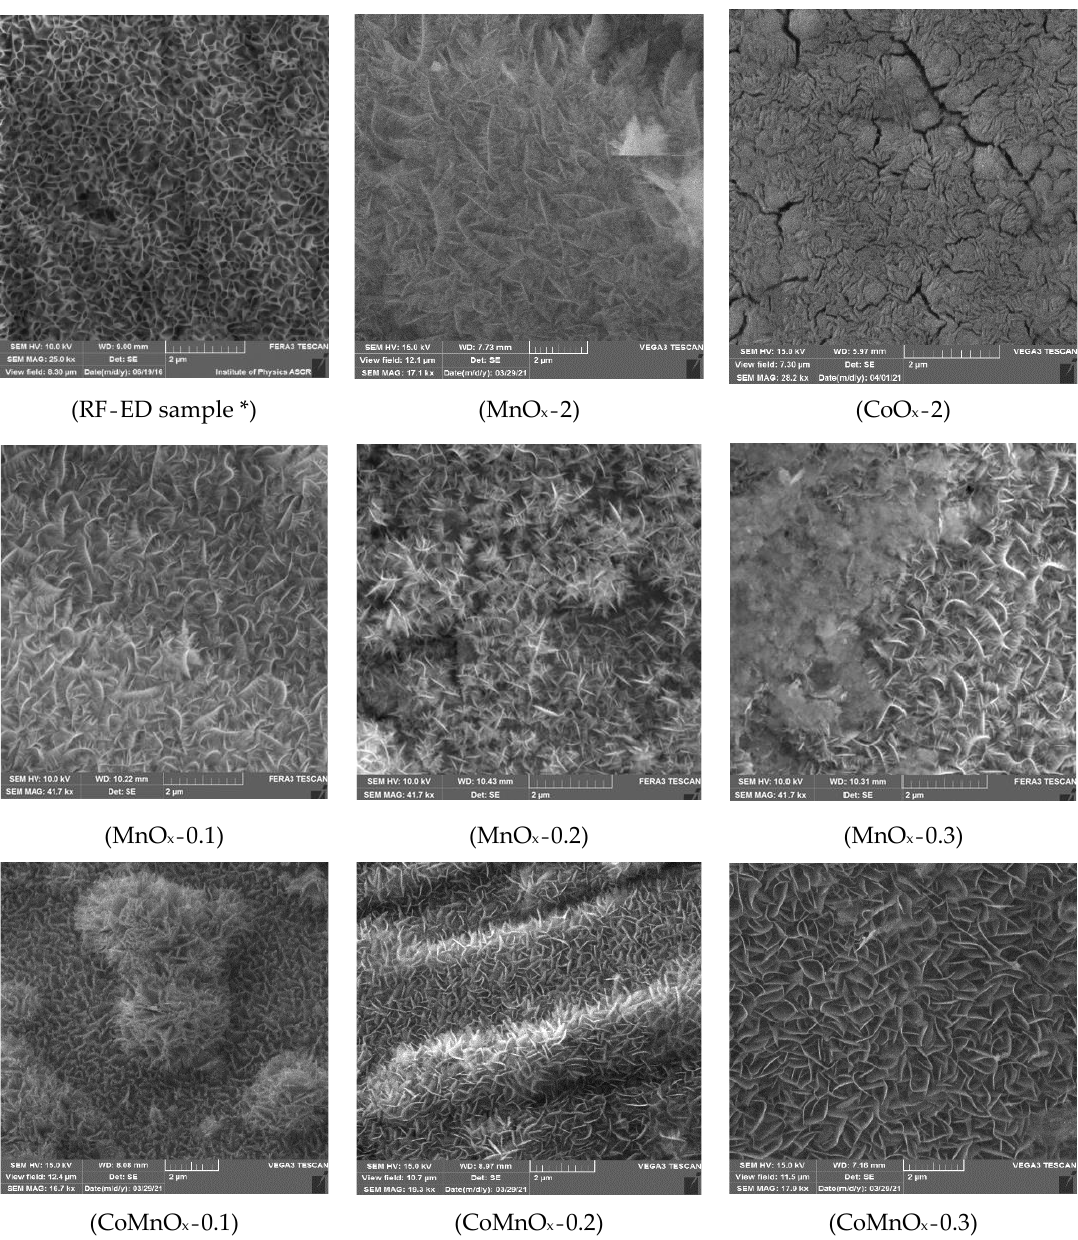
1 Figure 2. Surface morphology of the oxide layers deposited on the stainless steel supports (* the RF-ED sample with cobalt